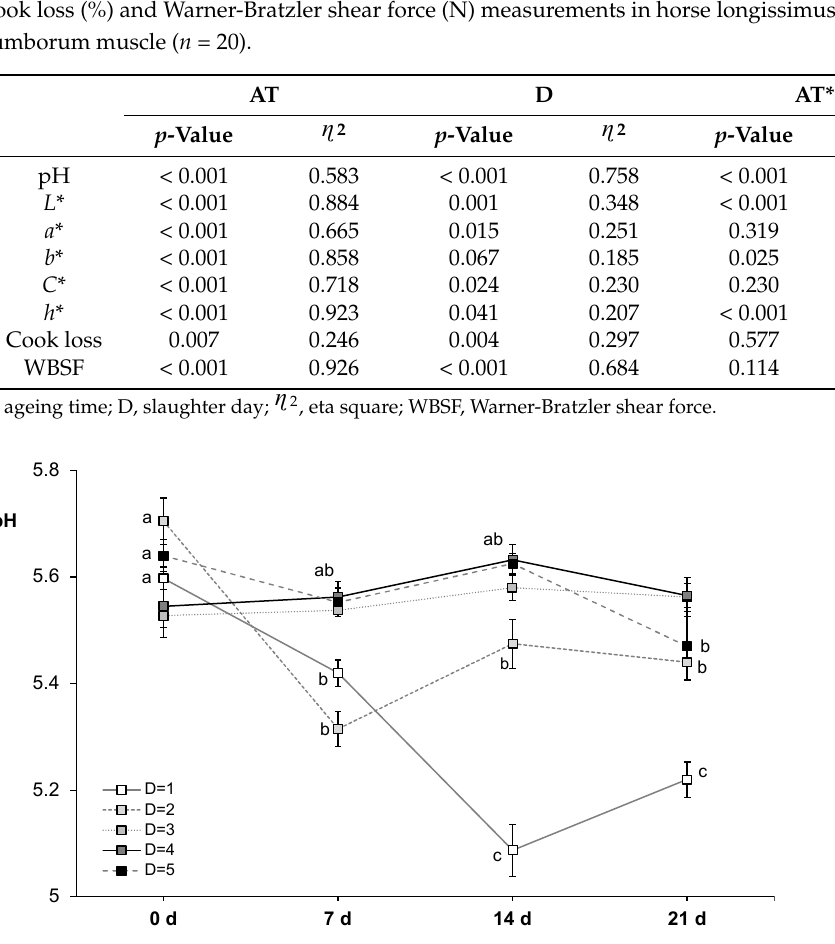
Figure 1. Interaction between ageing time (0, 7, 14 and 21 days) and slaughter day (D; 5 consecutive weeks) for pH measurements in horse longissimus thoracis and lumborum muscle ( n = 20). Mean val- ues and standard error of the means have been represented. Different letters indicate significant differences ( p ≤ 0.05) among ageing